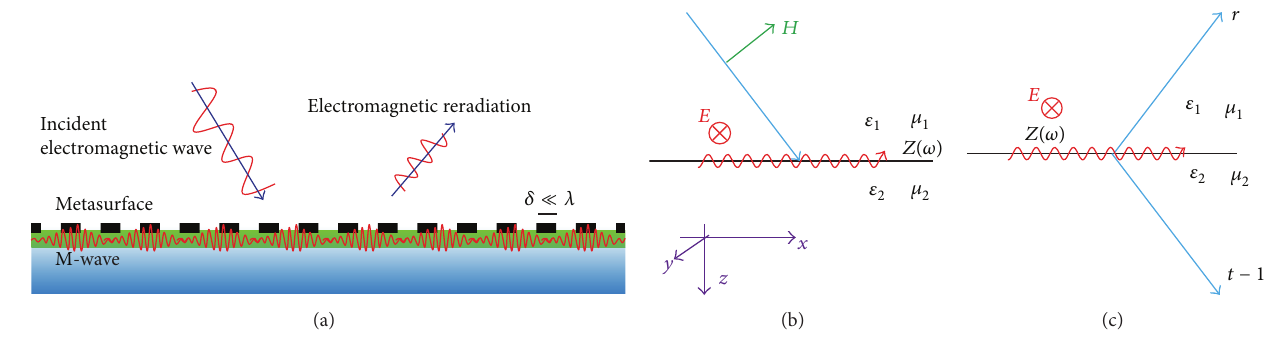
Figure 15: Exchange between the propagating waves and M-waves. (a) Schematic of the principle. (b) Excitation of M-wave by propagating wave. (c) Conversion of the M-wave to propagating wave. Figures are reproduced from [2]. achieved at the wavelength of ∼ 1.58 𝜇 m. At almost the same time, Liu et al. demonstrated an infrared perfect absorber and verified its application as plasmonic sensor